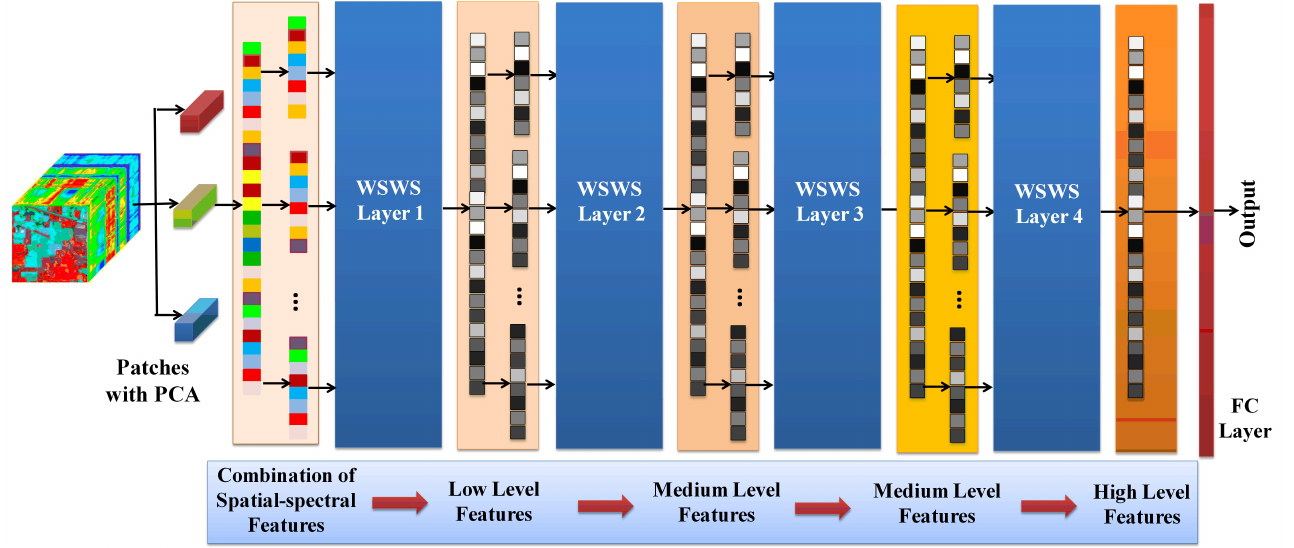
Figure 3. Learning spatial and spectral features using multiple WSWS